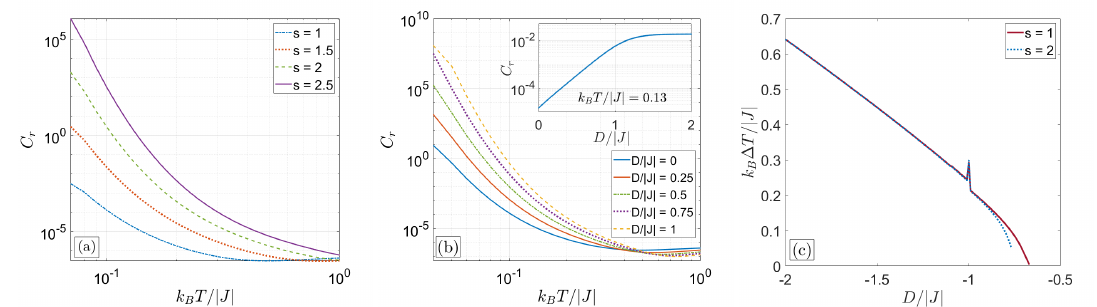
Figure 9. ( a , b ) Temperature dependencies of the cooling rates C r on approach to h f = 0 in the adiabatic process with the zero-field GS degeneracy in the 2CS cluster for ( a ) D / | J | = 0 and different spin values and ( b ) for s = 1 and different single-ion anisotropy. The inset in panel ( b ) shows the single-ion anisotropy dependence of C r for k B T / | J | = 0.13. ( c ) Single-ion anisotropy dependence of the temperature change when decreasing the initial field from h i = h c 1 to h f = 0 in the adiabatic process with the entropy corresponding to the ground-state degeneracy at h c 1 / | J |